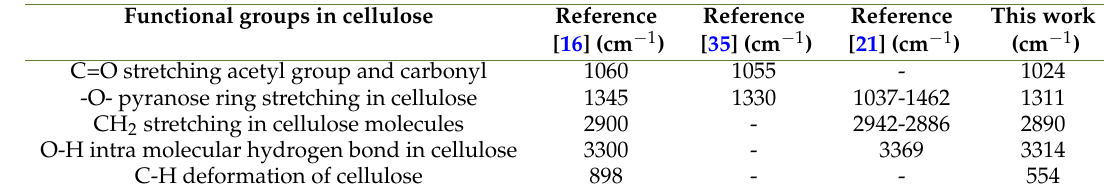
Table 5. The lignin removal, cellulose yield, and crystallinity index of OPEFB after pretreatment process.